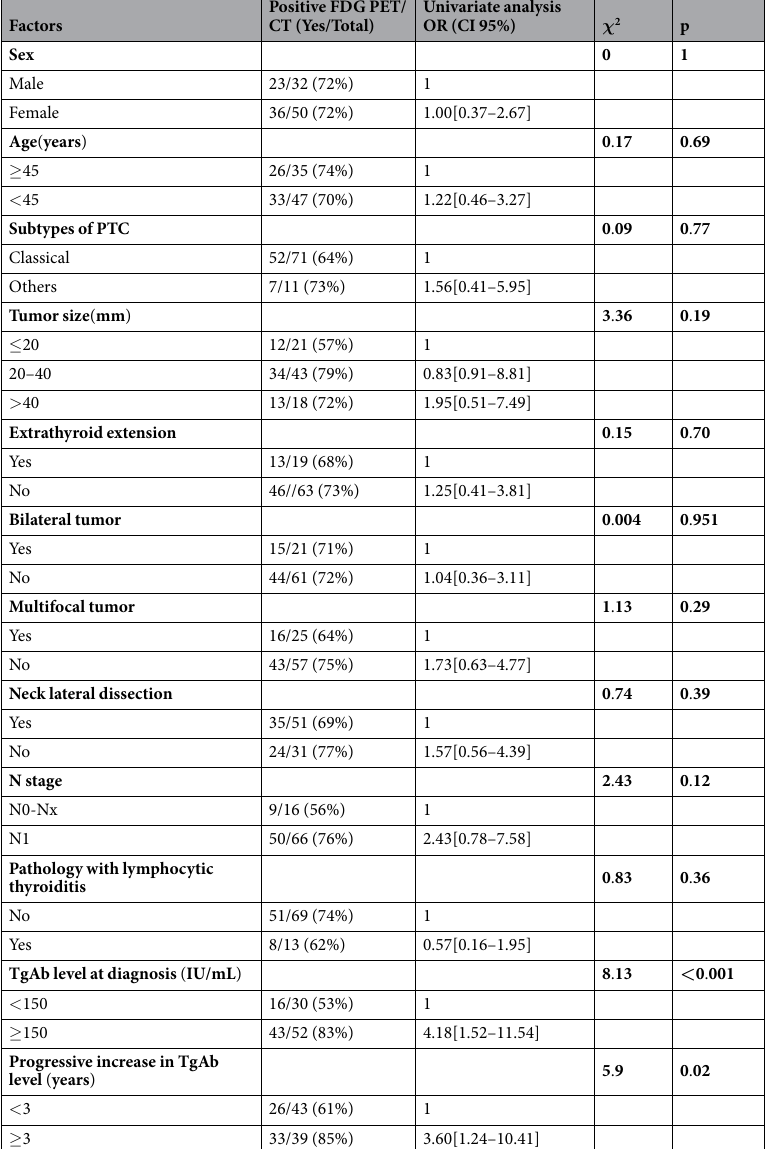
Table 4. Risk factors for positive 18 F-FDG PET/CT results in this specific